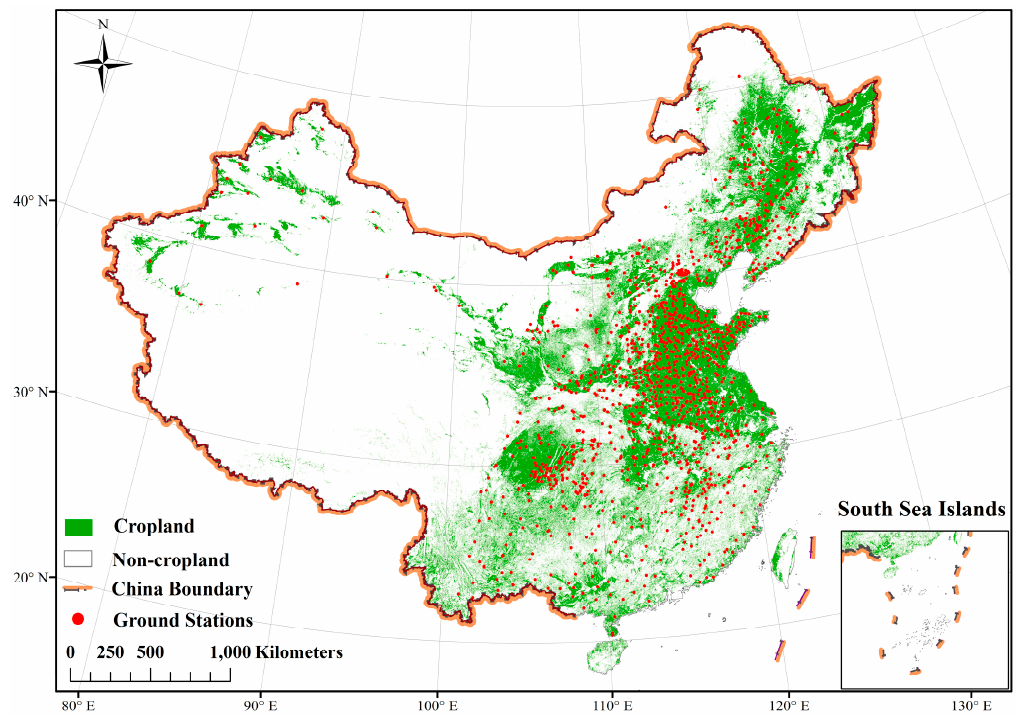
Figure 1. Ground stations for cropland soil moisture measurements in China.